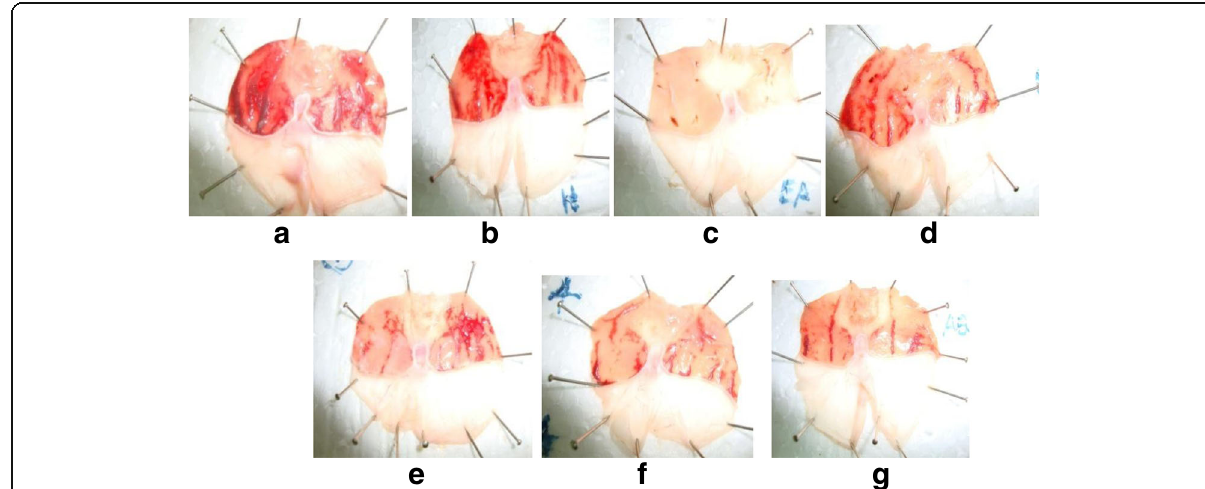
Fig. 2 Representative macroscopic photograph of stomachs of gastric lesions induced by absolute ethanol: a – animals received distilled water, b - animals received hexane fraction, c – animals received ethyl acetate fraction, d – animals received butanol fraction, e –